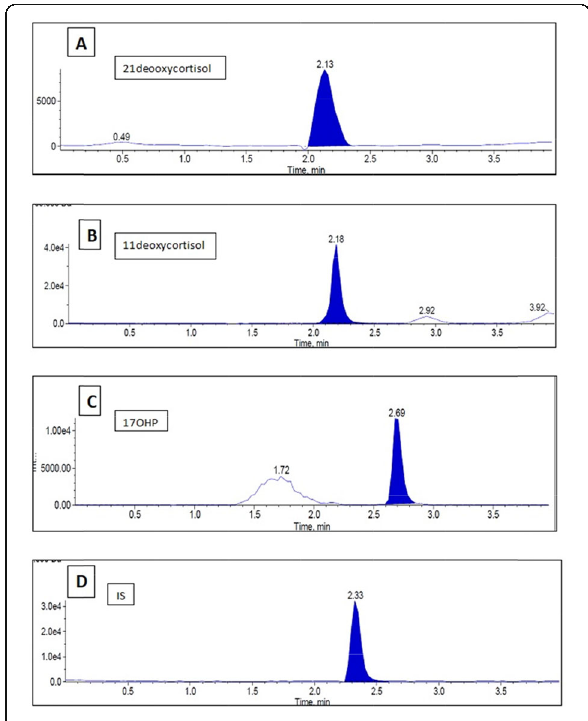
Fig. 1 a Chromatogram shows retention time of 21 deoxycortisol at 2.13 min, b shows the retention time of 11 deoxycortisol at 2.18 min, c shows the retention time of 17OHP 2.69 min, d shows the retention time of internal standard at 2.33